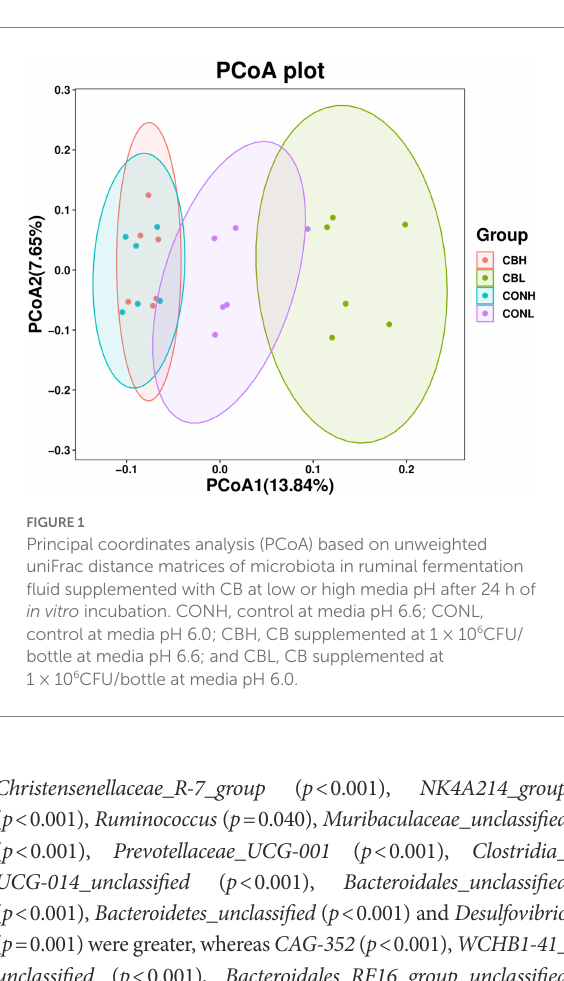
(Figure 1). The Venn diagram in the fermentation culture samples showed that the control and CB groups shared 2,971 OTUs, and had 2,164 and 1,963 exclusive OTUs (respectively) media pH 6.0